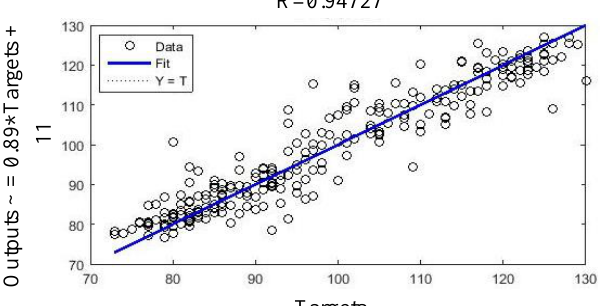
Fig. 16. Correlation between the targets and outputs for DWTNN model.